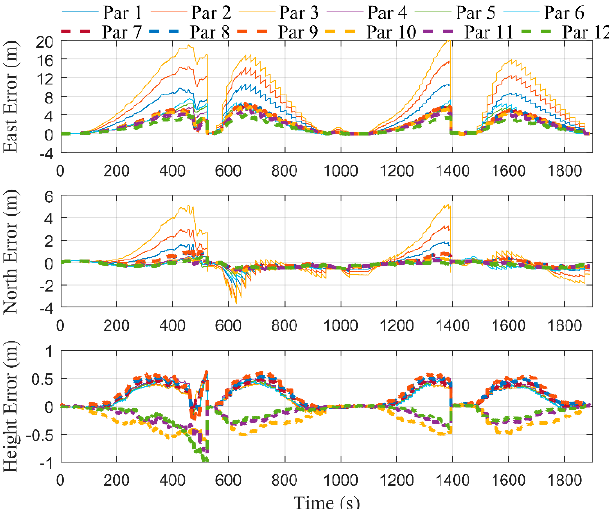
Figure 14. Positioning errors without performing RTS smoothing under different error parameters.